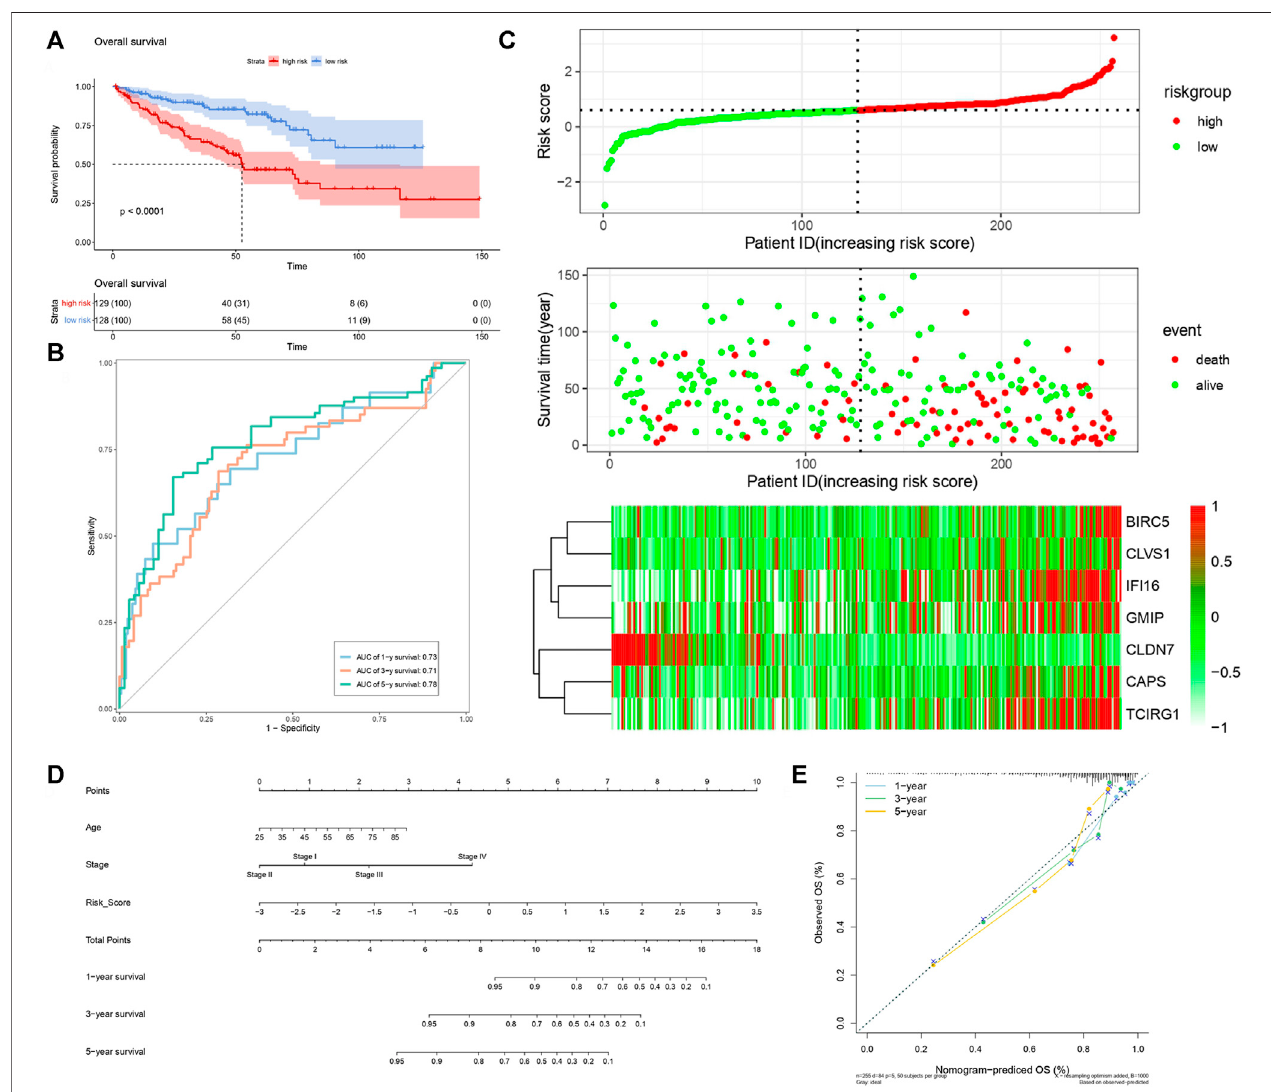
FIGURE8| Veri fi cation ofriskscoreaspredictingfactor ofccRCCpatientsinvalidationcohort. (A) Survivalcurve ofdifferentgroups.Red linerepresentedpatients in high risk group, blue line represented patients in low risk group. (B) Time-dependent ROC curve of 1-, 3-, 5-years. (C) Risk factor association diagram. Red nodes in the upper and middle graph represented patients with high risk score, green nodes represented patients with low risk score. Cells in the gram below represented each patient, and color of cells indicated up- or down-regulation of genes. (D) Nomogram included age, stage, and 7 gene-based risk score. (E) Calibration curve was depicted for veri fi cation accurancy of nomogram predicting 1-, 3-, 5-years OS rate.